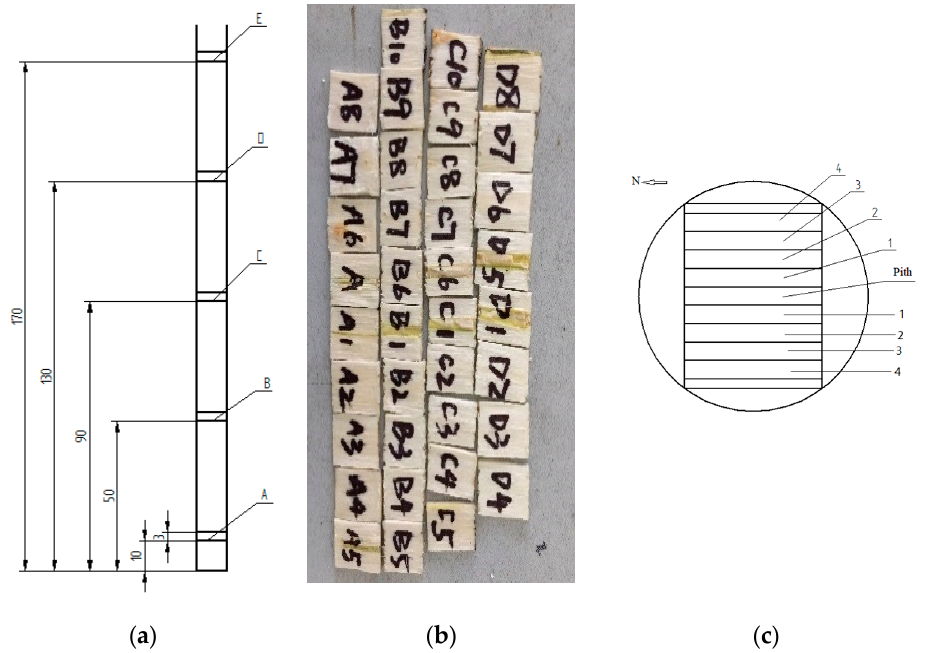
Figure 1. Schematic diagram of specimen preparation for MFA measurement: ( a ) disc sample position; ( b ) specimen sampling from cross-section; ( c ) specimens from discs A, B, C, and D of P-146 poplar seedlings.